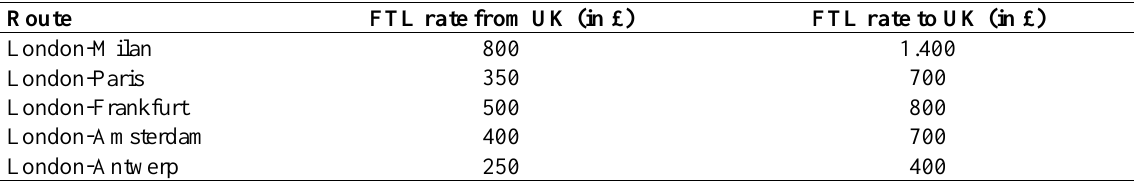
Table 1. Road haulage rates on various connections (1993/1994) Route FTL rate from UK (in £) FTL rate to UK (in